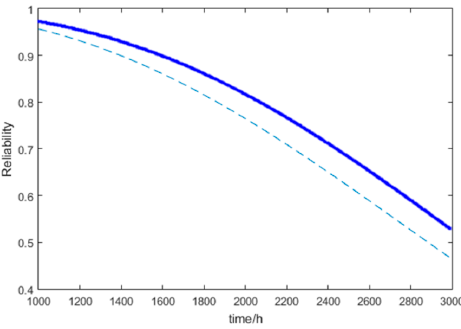
Figure 3. Reliability Estimation Curve.